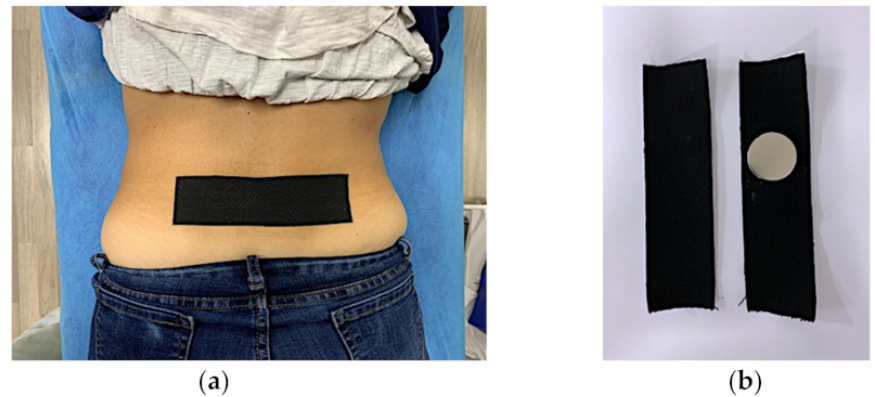
Figure 3. Magnetic Tape ® and Kinesio tape application. Tape application in lumbar region ( a ) and tape preparation, only neodymium magnet allow identification ( b